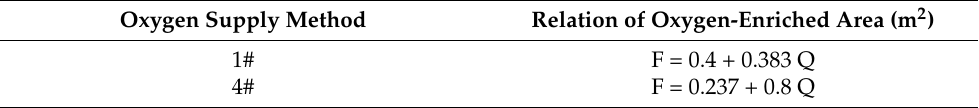
Figure 11. Oxygen-enriched area with different oxygen supply modes and oxygen flow rates un- der air-conditioning. Table 6. The relationship between oxygen-enriched area and oxygen flow rate under air-condi- tioning.